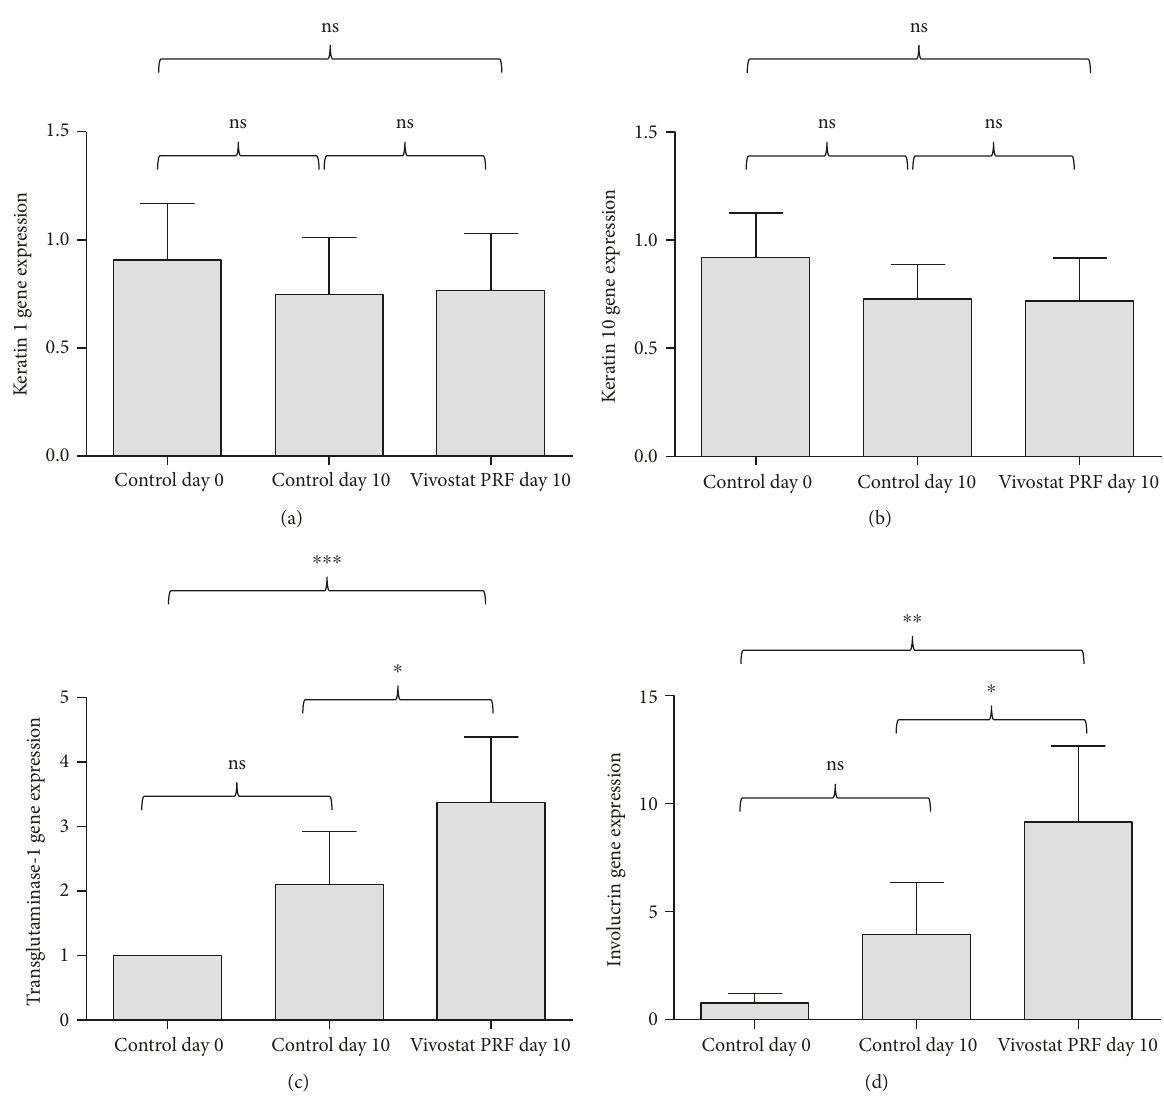
Figure 7: Vivostat PRF treatment caused a signi fi cant transglutaminase-1 and involucrin gene induction in vivo. In our in vivo study, we observed a signi fi cant induction of transglutaminase-1 and involucrin gene expression in Vivostat PRF-treated keratinocytes. Vivostat PRF treatment caused an insigni fi cant decrease of keratin 1 and keratin 10 gene expression in human keratinocytes in vivo (real-time PCR analysis, ∗ P < 0 05 , ∗∗ P < 0 01 , ∗∗∗ P < 0 001 , ns =not signi fi cant, one-way ANOVA with Tukey ’ s multiple comparison